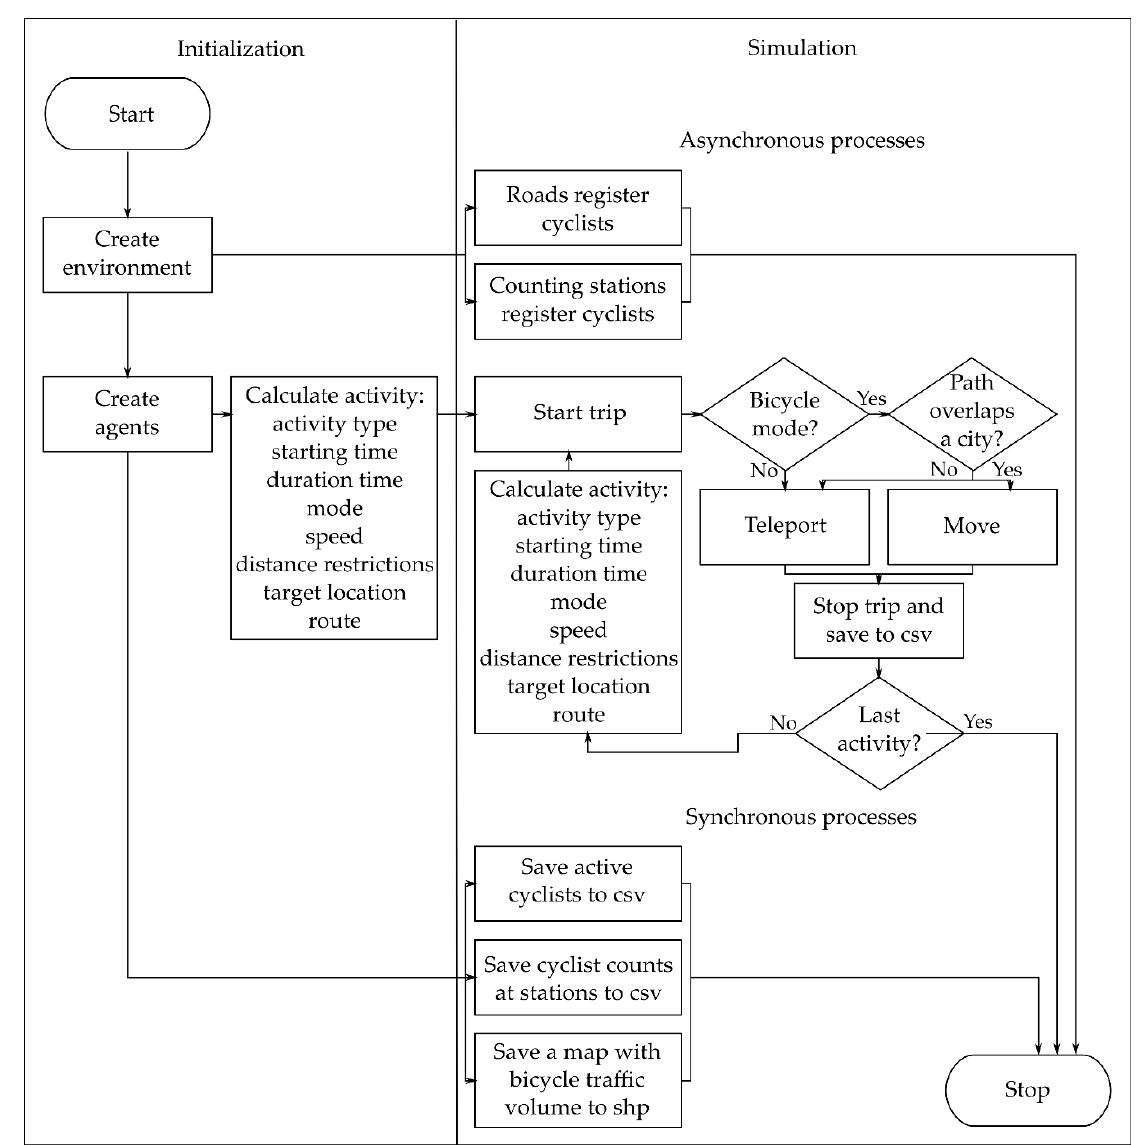
Figure 2. The flowchart of the processes in the bicycle model.